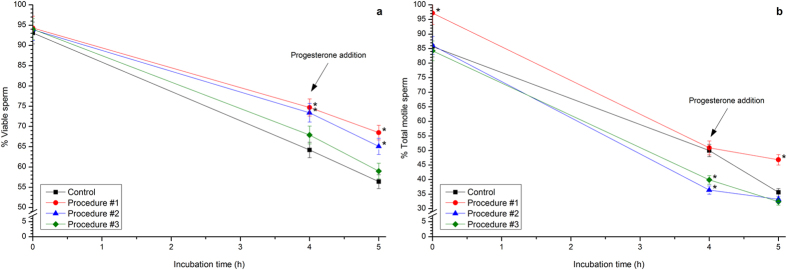
Percentages of viability and total motility of boar sperm cells subjected to ‘in vitro’ capacitation and subsequent progesterone-induced ‘in vitro’ acrosome exocytosis after photo-stimulation procedures.Boar sperm were subjected to separate photo-stimulation procedures and the subsequent IVC/IVAE as described in the Methods section. At the indicated times, aliquots were taken and percentages of viability (a) and total motility (b) were determined. 0: values at 0 h of incubation in the capacitation medium (CM). 4: values at 4 h of incubation in the CM. 5: values after 4 h IVC plus 60 min of the progesterone-induced IVAE. Results are shown as mean ± SEM for 12 separate experiments. Asterisks indicate significant (P < 0.05) differences when compared with the respective Control value at the same time point.